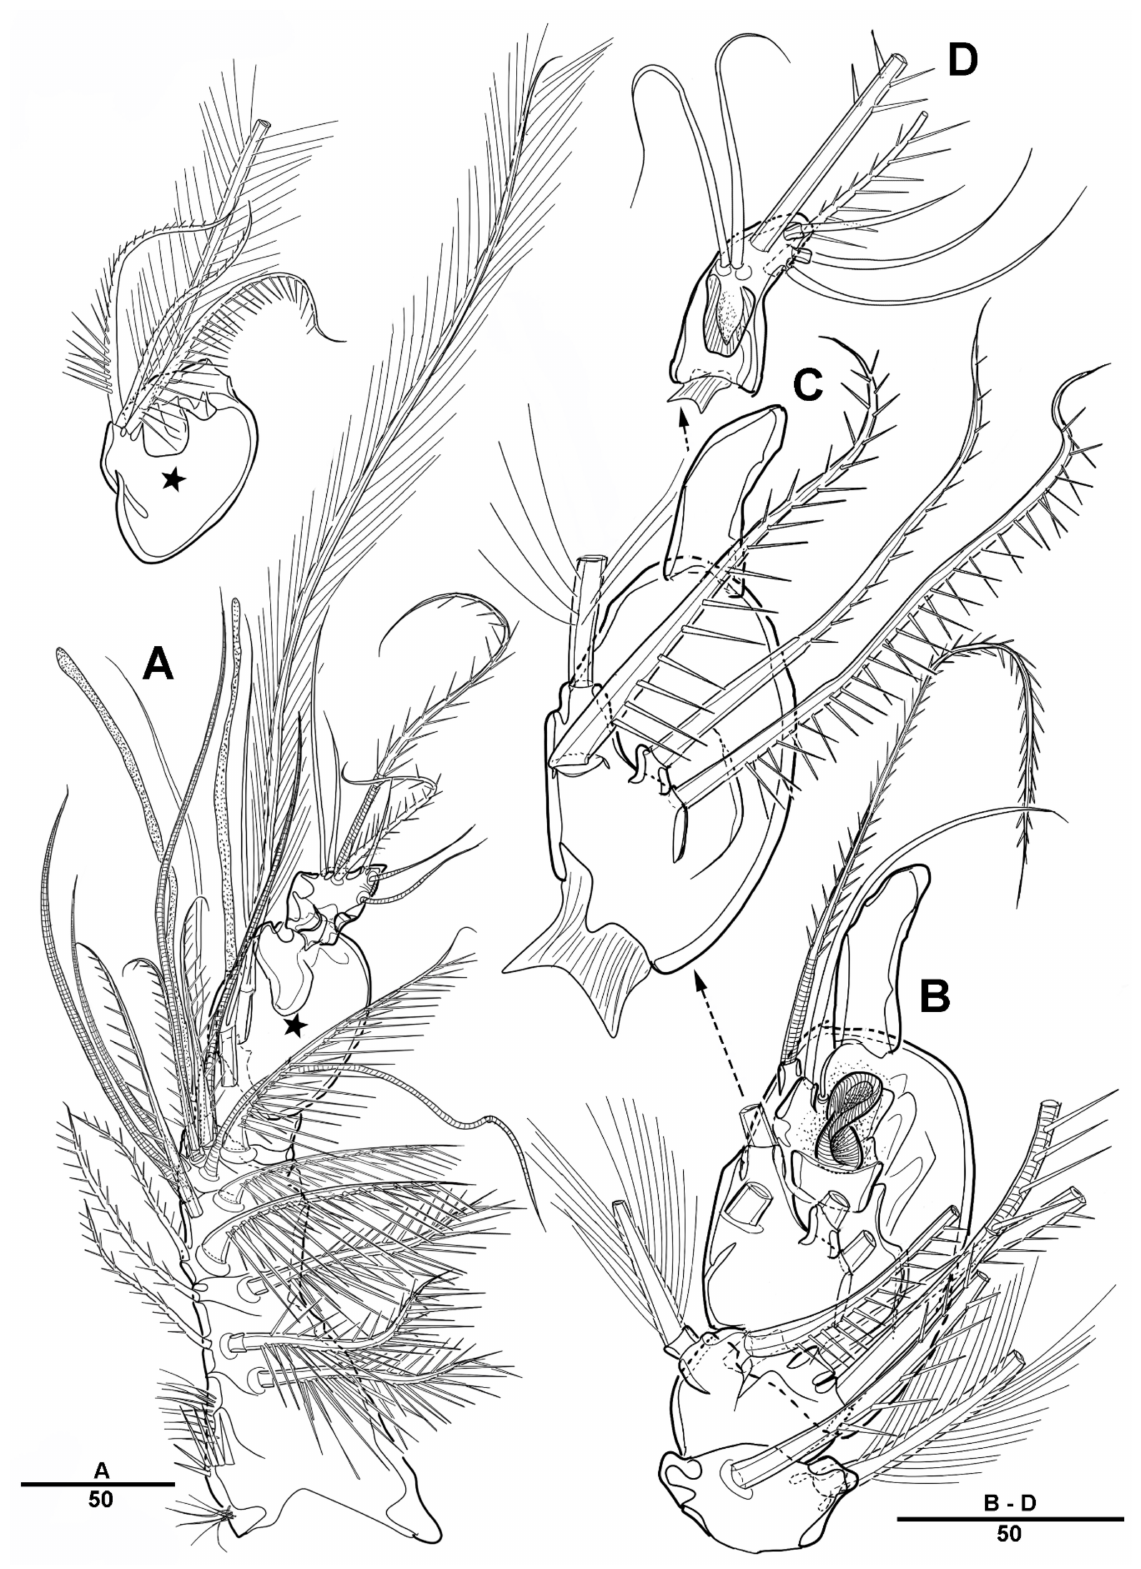
Figure 20. Scottolana wonchoeli sp. nov. paratype male: ( A ) antennule, dorsal (asterisk showing armature on proximal half of segment 4); ( B ) antennulary segment 2–4, anterior; ( C ) antennulary segment 4, anterior (armature of segment 5 omitted); ( D ) antennulary segment 5, anterior. Scale bars in µ